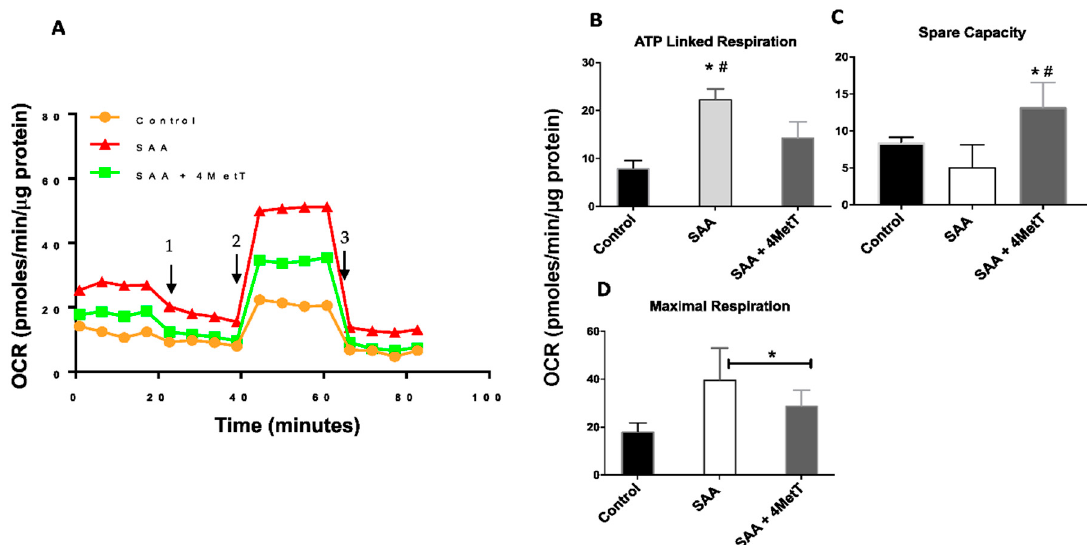
Figure 8. Effect of SAA and 4-MetT on cultured primary HAEC mitochondrial respiration. ( A ). Oxygen consumption rate profile (OCR); arrows indicate injection points for 1: oligomycin; 2: FCCP; 3: Rotenone/Antimycin. ( B ). ATP linked respiration ( C ). Spare respiratory capacity ( D ). Maximal respiration. Data represent mean ± SD, n = 5 per group. All data was normalised against corresponding total cellular protein * Different to control in the absence of SAA, p < 0.05. # Different to SAA-treatment group, p ≤ 0.001.